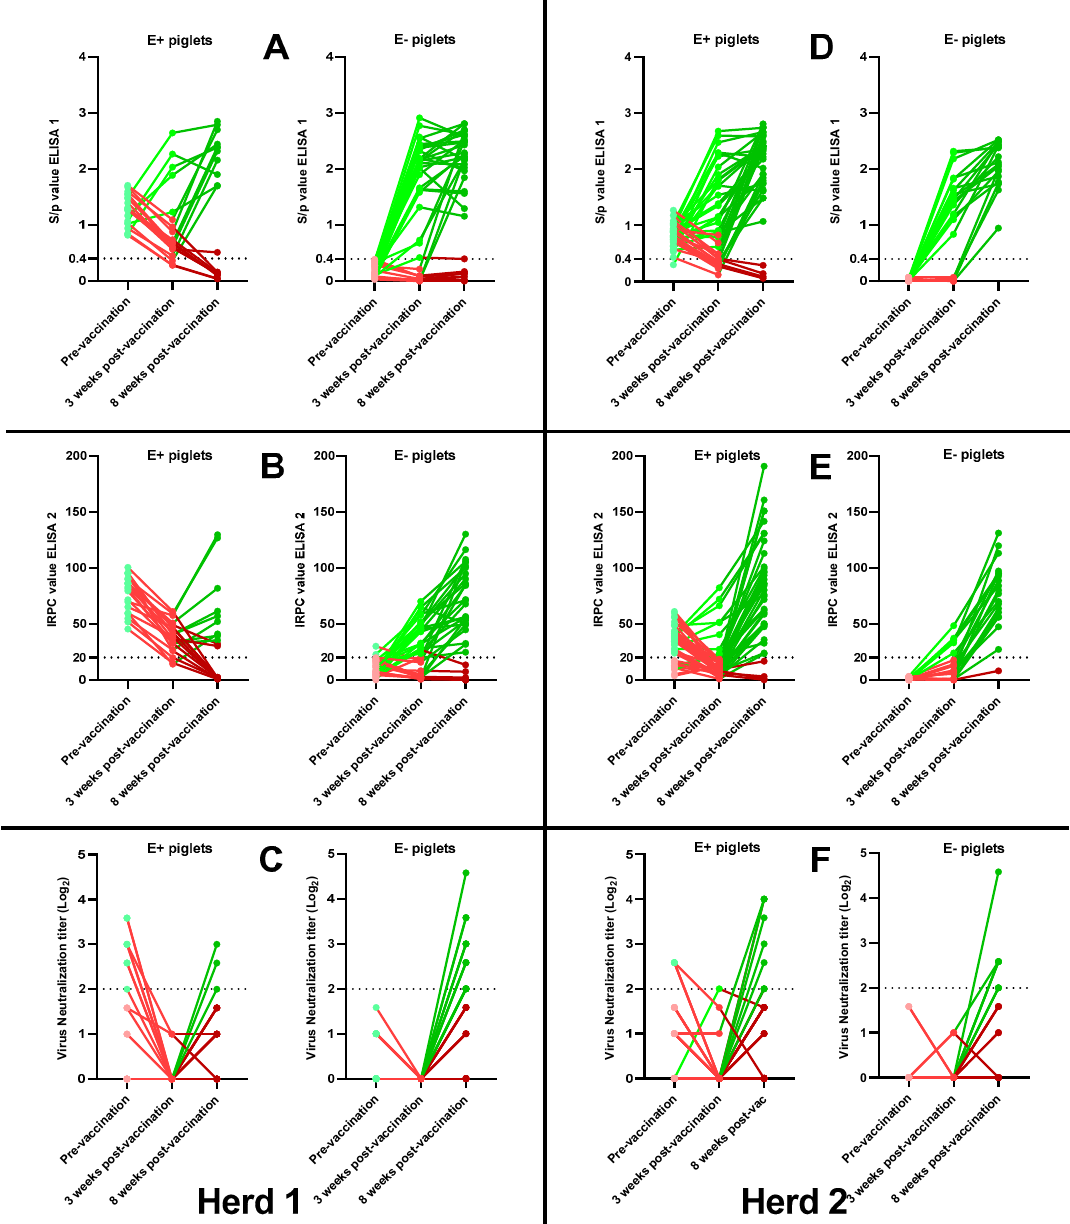
Figure 3. PRRSv-antibody responses in PRRSv-vaccinated piglets born from PRRSv-vaccinated seropos- itive sows (E+ piglets) and PRRSv-vaccinated seronegative sows (E − piglets) in two Belgian farrow-to- finish herds. Piglets in herd 1 ( A – C ) were intramuscularly PRRSv-vaccinated at 3 weeks of age with the Porcilis ® vaccine. Piglets in herd 2 ( D – F ) were intramuscularly PRRSv-vaccinated at 4 weeks of age with the Unistrain ® vaccine. Antibody responses at 3 and 8 weeks post-vaccination were analyzed using IDEXX ELISA (A + D; ELISA 1), CIVTEST ELISA (B + E; ELISA 2) and virus neutralization assay (C + F; VN). Individual S/ p values (ELISA 1), IRPC values (ELISA 2) and Log 2 VN titers are shown as dots with lines connecting the values pre-vaccination, 3 weeks post-vaccination and 8 weeks post-vaccination for each piglet. Light green lines indicate the presence of an antibody response at 3 weeks post-vaccination, while dark green lines indicate the presence of an antibody response by 8 weeks post-vaccination. Light red lines indicate the absence of an antibody response at 3 weeks post-vaccination, while dark red lines indicate the absence of an antibody response by 8 weeks post-vaccination. Cut-off values for seropositivity are included in each graph as a dotted horizontal